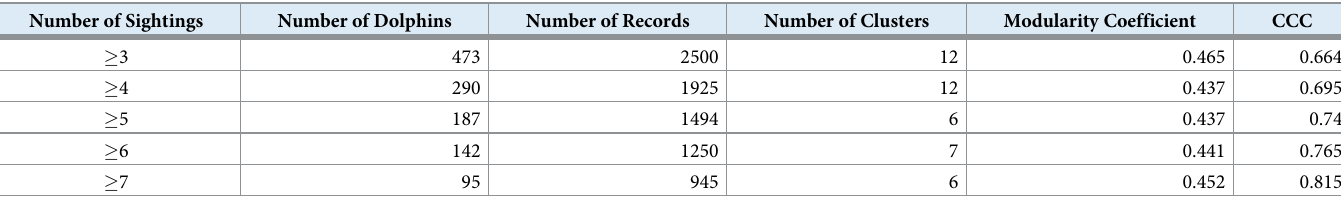
Results of social network analyses conducted for estuarine-resident common bottlenose dolphins in waters of North Carolina, US. The analysis was run for individuals with the number of sightings ranging from � 3 to � 7, with a corresponding decreasing number of unique individuals (Number of Dolphins) and the total number of sightings for those individuals (Number of Records). The Number of Clusters is the optimal number of clusters resulting from the network analysis for each number of sightings. Modularity values > 0.3 indicate those clusters are representative of the true social structure. CCC, Cophenetic Correlation Coefficient, values > 0.8 indicate that the resulting clusters reasonably represent the association